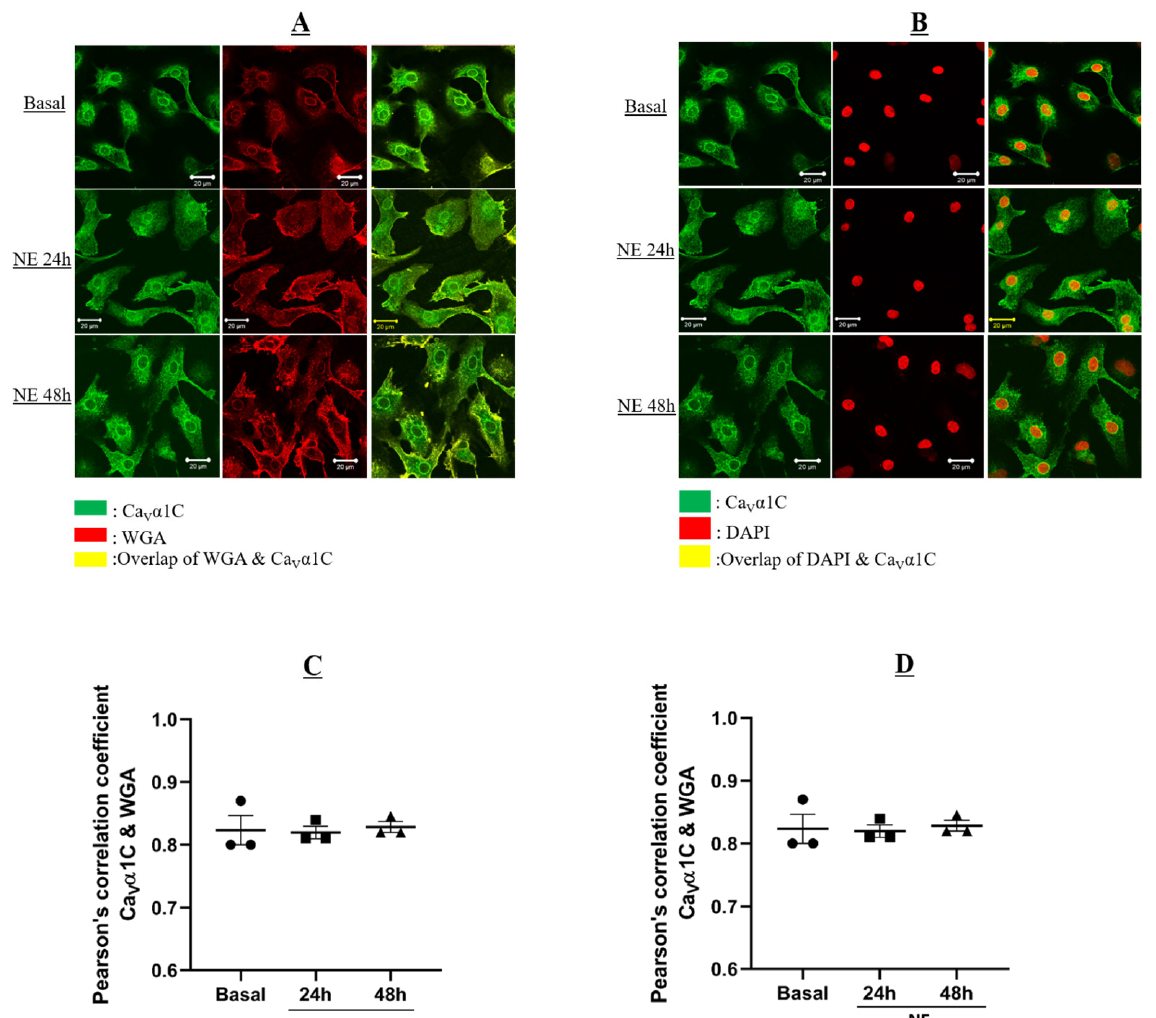
Figure 4. Neonatal rat cardiomyocytes in basal condition or treated with NE for 24–48 h. WGA-Alexa 647 was added to live cardiomyocytes at room temperature followed by fixation with 2% PAF for 20 min at room temperature. Cardiomyocytes were then permeabilized with 0.2% Triton-X. Primary antibody: mouse anti-Troponin-T and rabbit anti-Ca V a1C were added for 90 min at room temperature, followed by overnight incubation at 4 ◦ C. This was followed by incubation of secondary antibodies: goat anti-mouse Alexa 555; Donkey anti-rabbit Alexa 488, and DAPI for 90 min at room temperature in the dark. Images were captured by microscope with 20 × objective. Images were analyzed using ZEN software. ( A ) Images showing colocalization of WGA and Ca V α 1C. Green: Ca V α 1C; Red: WGA; Yellow: Overlap between Ca V α 1C and WGA. ( B ) Images showing colocalization of DAPI and Ca V α 1C. Green: Ca V α 1C; Red: DAPI; Yellow: Overlap between Ca V α 1C and WGA. ( C ) Graph showing Pearson’s correlation coefficient of the overlap between WGA and Ca V α 1C. ( D ) Graph showing Pearson’s correlation coefficient of the overlap between DAPI and Ca V α 1C. Pearson’s correlation coefficient of the overlap is determined using ImageJ.